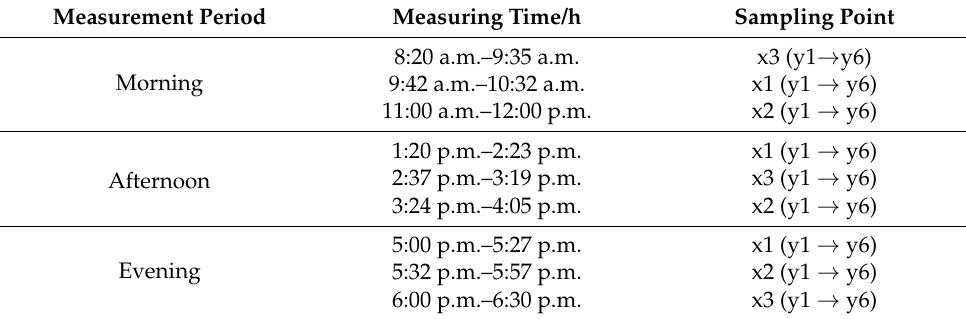
Table 1. Schedule for the friction coefficient